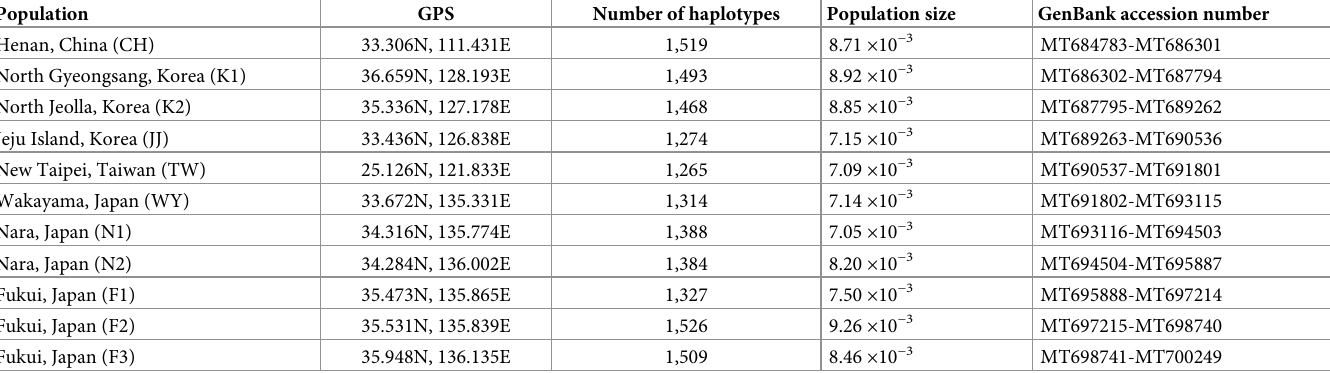
Table 1. Global-Positioning System (GPS) coordinates, population size estimated using Migrate-n analysis, the number of D-loop haplotypes of M . fuliginosus , and GenBank accession numbers of D-loop sequences. Population